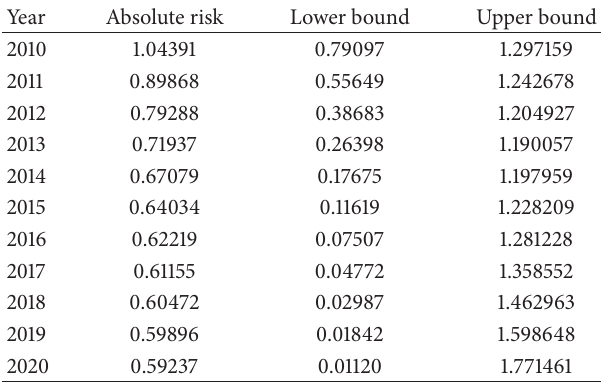
Table 2: Forecasted absolute values of Cambodian fatality risk (i.e., number of fatalities per thousand motor vehicles) in the years 2010– 2020, including their 68% confidence limits.